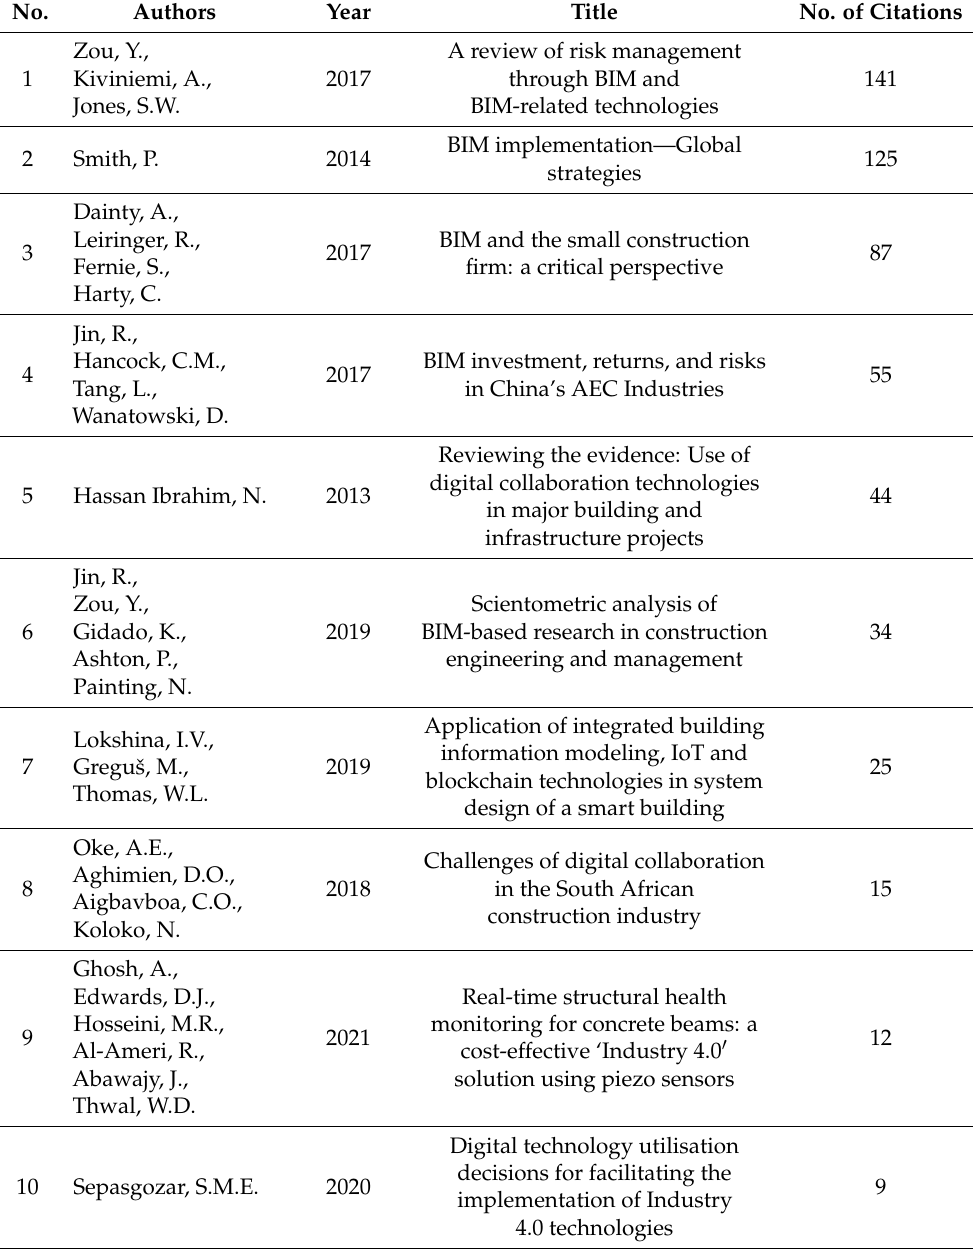
Table 2. Top ten cited papers from the